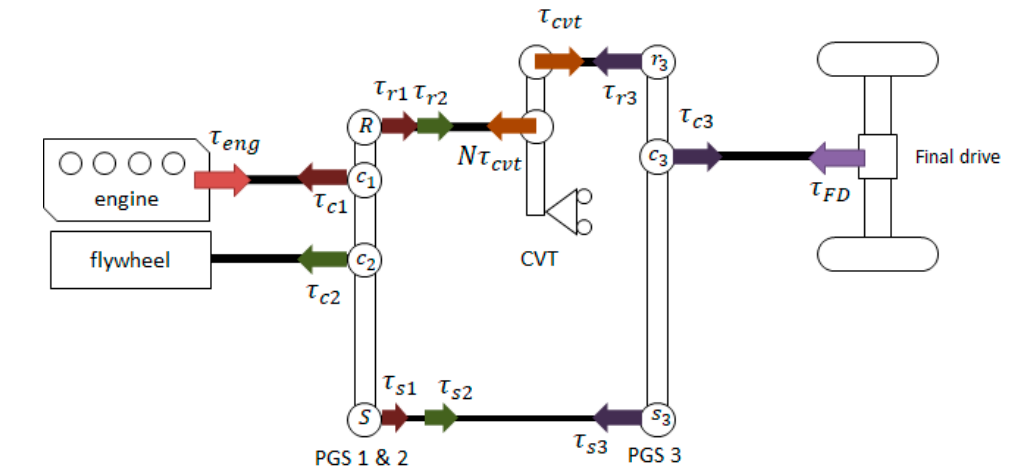
Figure 8. Free body diagram of the PS-FHV using the lever analogy.